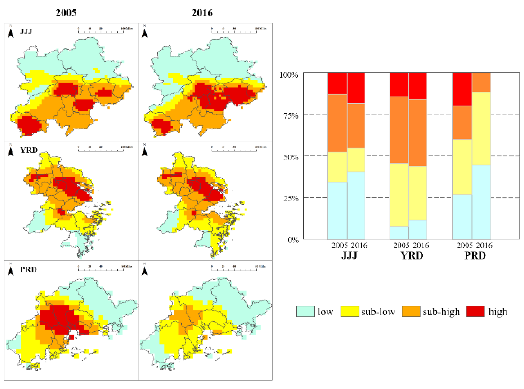
Figure 3. The spatial distribution and the proportions of HPC in JJJ, YRD and PRD in 2005 and